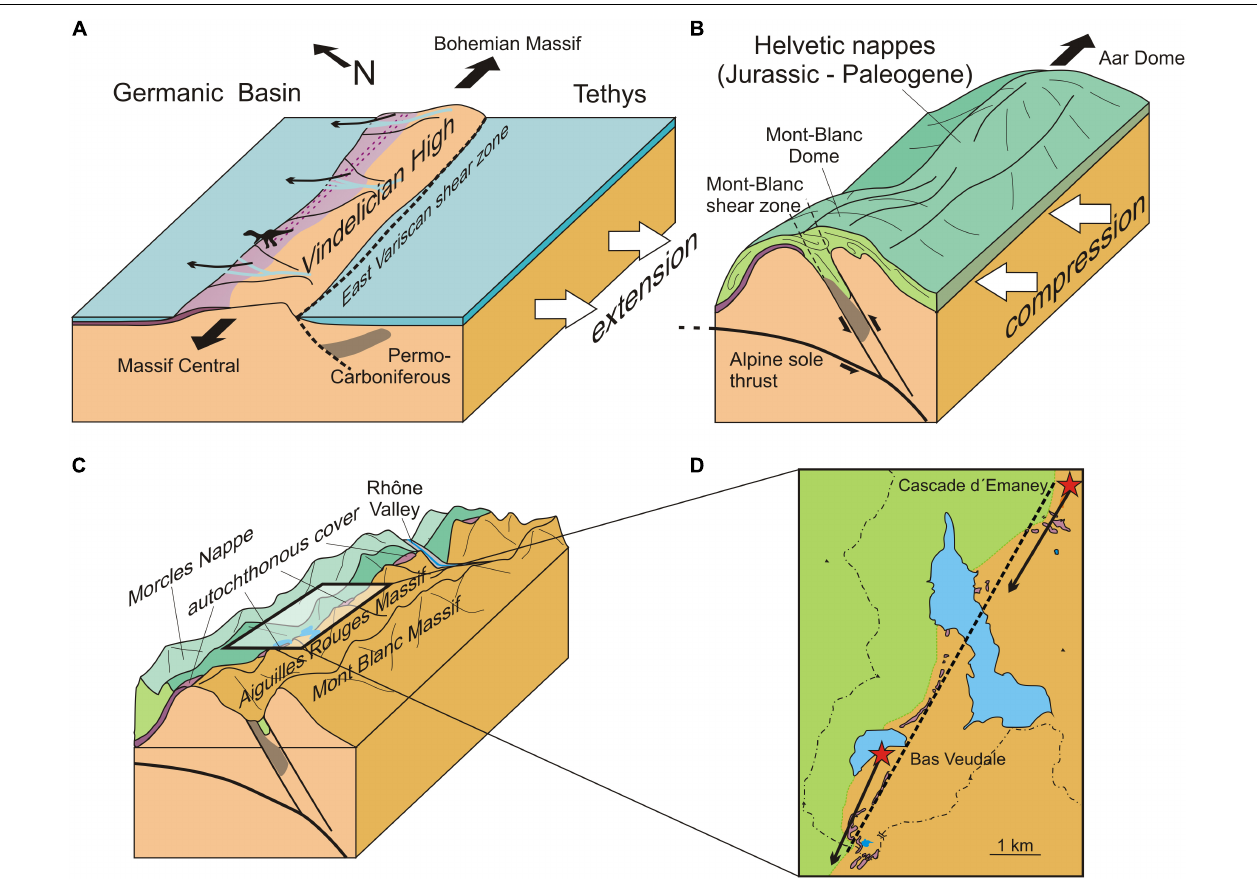
FIGURE 4 | Highly schematic representation of the paleogeographic and tectonic evolution of the study area, illustrating the basis of the correspondence between the alignment of the Triassic outcrops and the direction of both trackways (not to scale). (A) Triassic, the archosaurs move along the Vindelician High that separated the Tethys Ocean from the Germanic Basin during the beginning of the Tethyan rifting; (B) Miocene, the trackway bearing layers are uplifted and tilted during the Alpine orogeny; (C) Recent, erosion exposes the levels with the trackways; (D) Recent, simplified geological map. The dotted line indicates the alignment of the outcrops and the arrows indicate the orientation of the trackways. Adapted from Ballèvre et al. (2018) (A) ; von Tscharner et al. (2016) (B) ; Leloup et al. (2005) (B,C) .